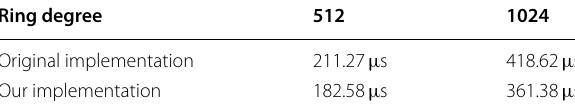
Table 3 Signature generation time of FALCON at 3.6 GHz